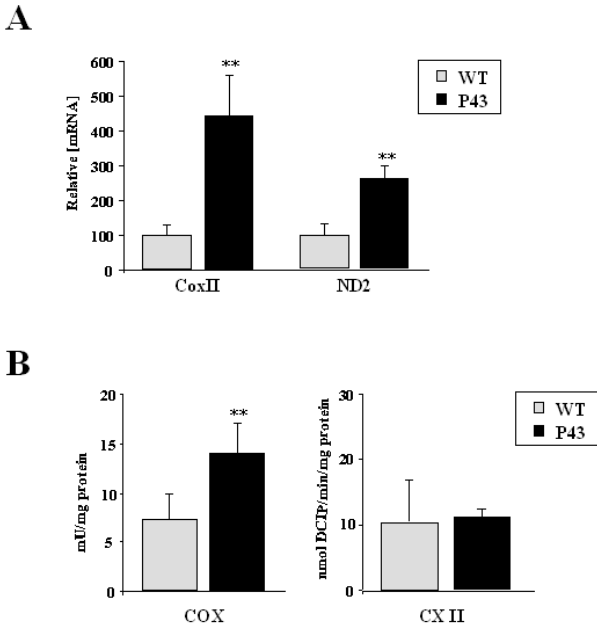
Figure 2. p43 overexpression increases mitochondrial tran- scription and mitochondrial activity. (A) Relative mRNA expression levels of mitochondrial transcripts (COXII and ND2) in quadriceps muscle from transgenic mice of the 86 line compared to wild-type animals at 2 months of age (n=8 each group). **p , 0.01. (B) Enzymatic activities of mitochondrial respiratory chain complexes in quadriceps muscle from transgenic mice of the 86 line compared to wild-type animals at 2 months of age (n=8 each group). COX: cytochrome c oxydase; CXII: complex II. **p , 0.01.